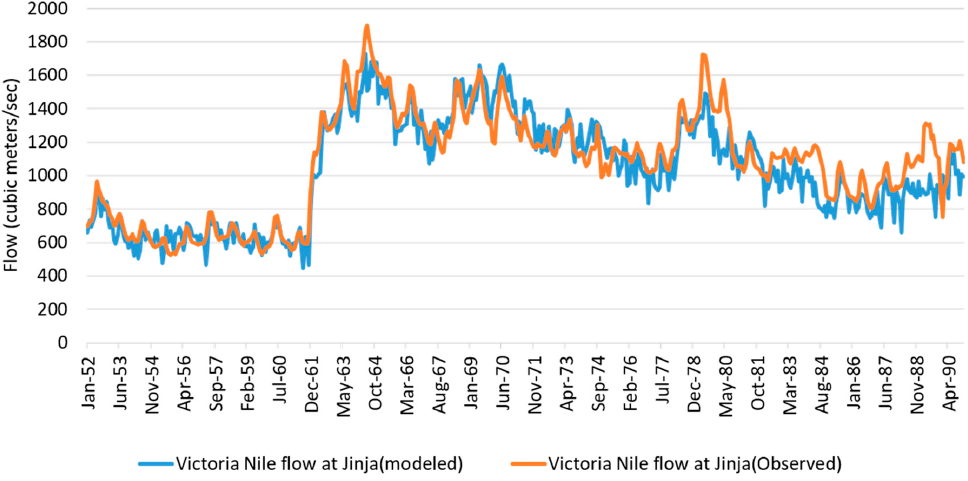
Figure 4. Flow calibration of the water evaluation and planning (WEAP) model at Jinja (the inlet of Lake Victoria into mainland Lake Victoria into mainland Uganda).